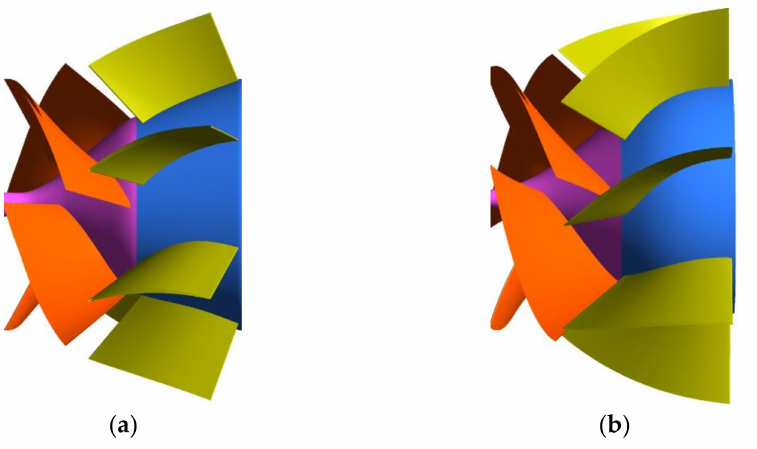
Figure 11. Geometric comparison of impeller and diffuser. ( a ) Initial scheme. ( b ) Optimized